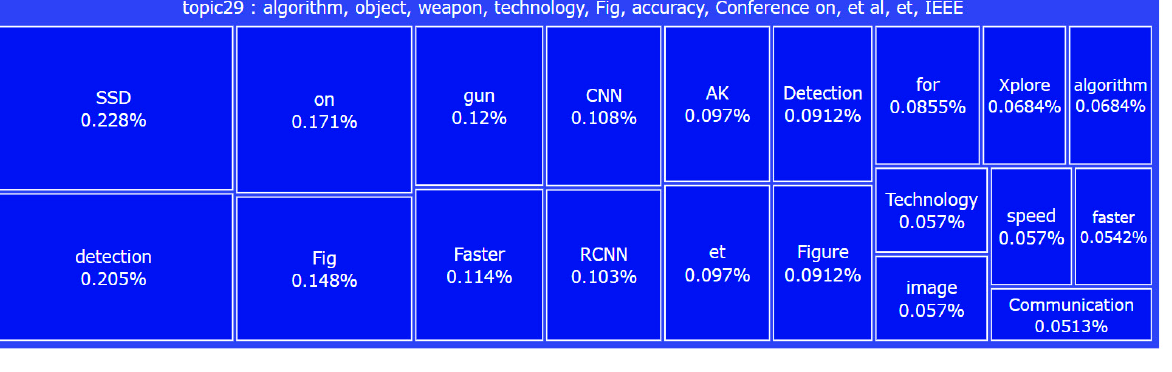
Figure 6. DT-model tree map.